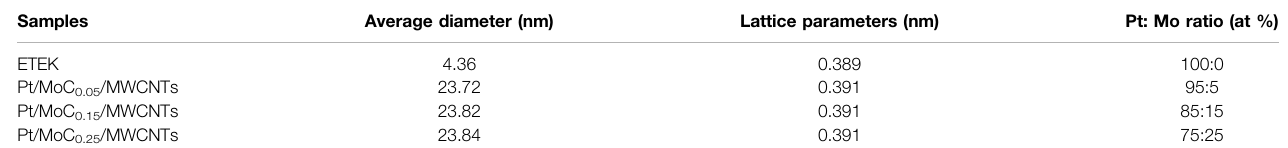
TABLE 1 | Physicochemical parameters of different sample. Samples